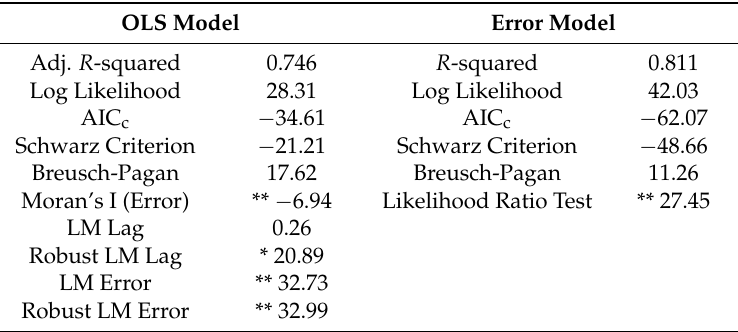
Table 6. OLS and error model statistics.